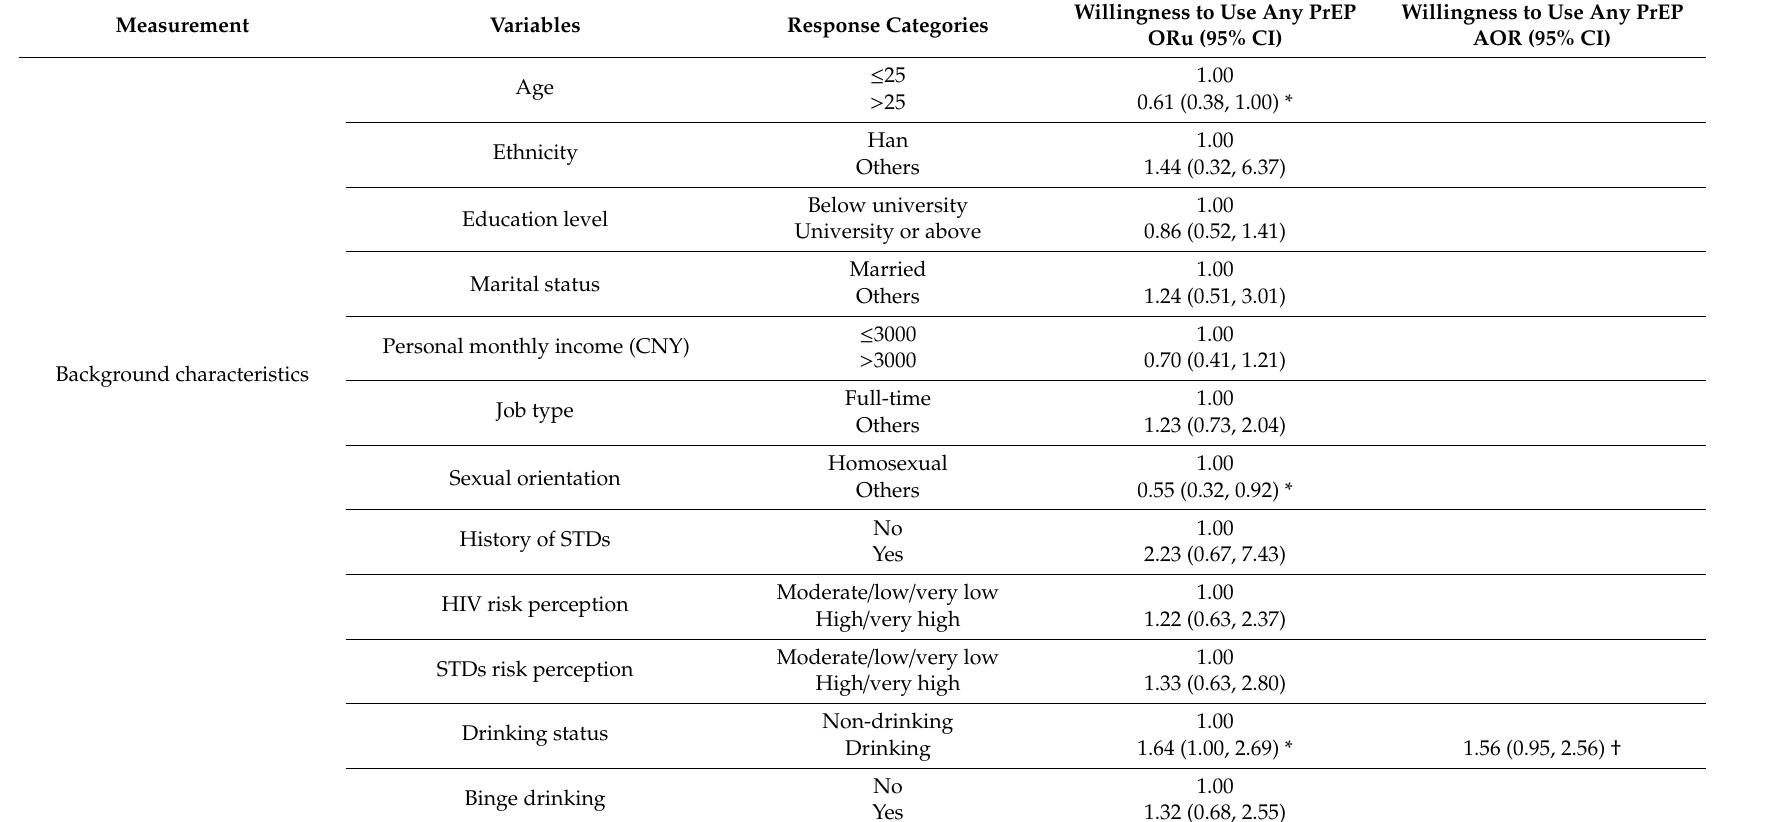
Table 3. Association between variables and the willingness to use any